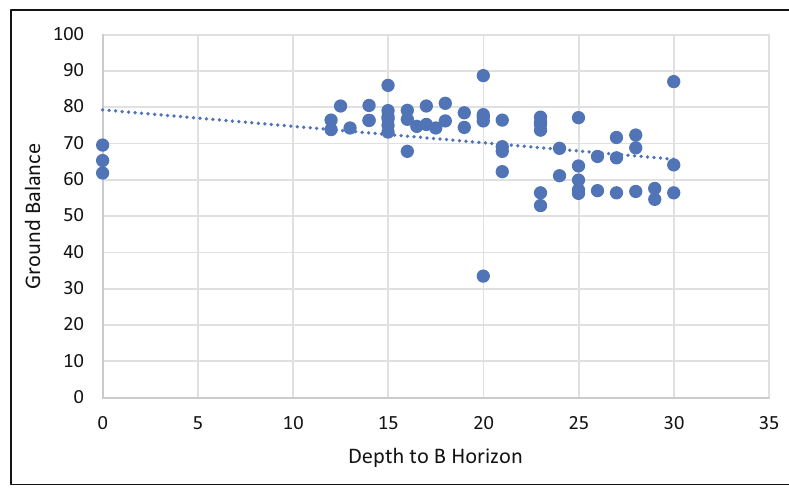
Figure 12: Linear regression of ground balance readings over subsoil depth. N